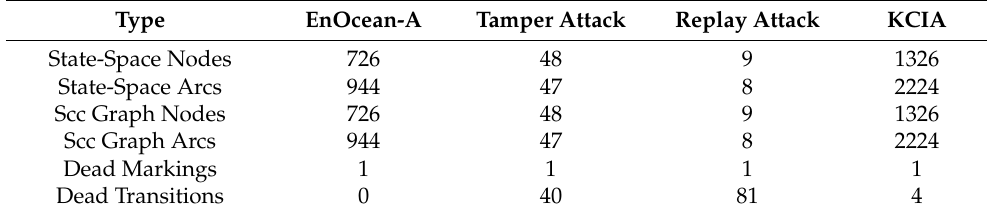
Table 7. State-space analysis of EnOcean-A